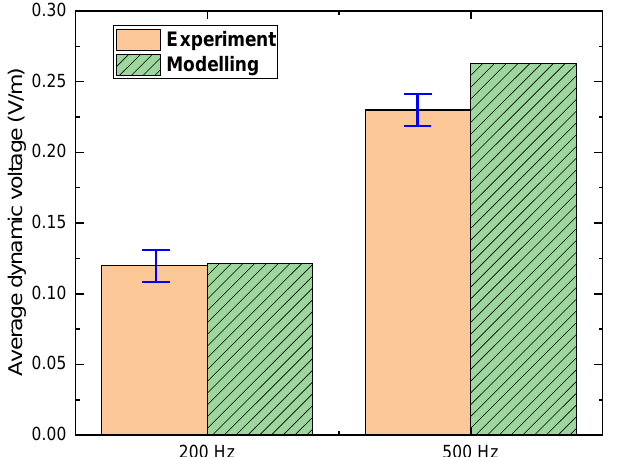
Figure 5. Experiment vs modelling: the average dynamic voltage of a 6 mm HTS tape ( I c = 135 A), carrying a 80 A DC transport current and in the presence of the perpendicular AC magnetic field at 100 mT with the frequencies at 200 Hz and 500 Hz.